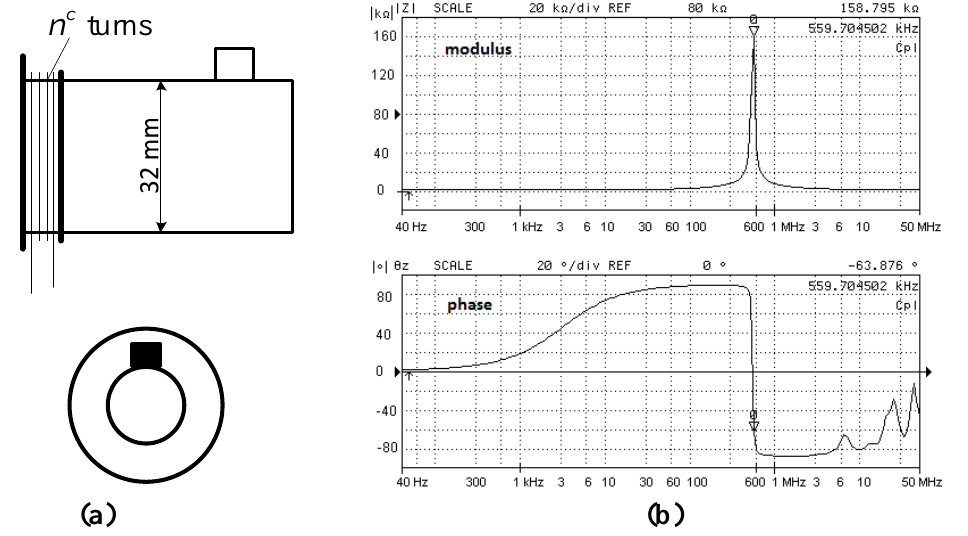
Figure 1. Flux coil sensor: (a) design and symbol; (b) frequency